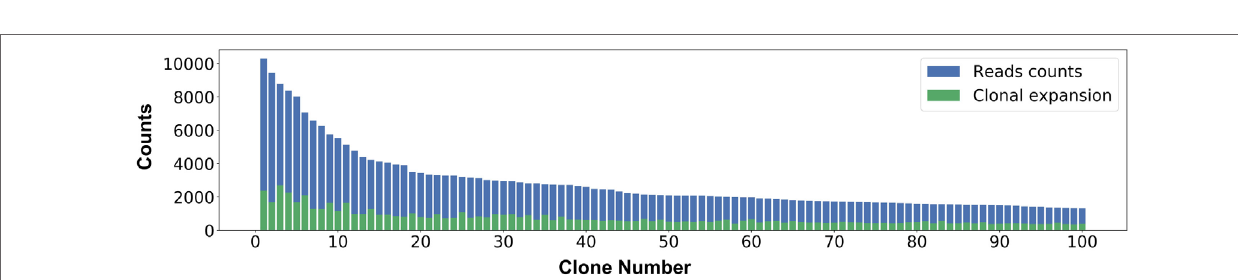
FIguRe 8 | Clonal expansion. The X axis shows the most prevalent 100 clones. For each clone, the Y axis represents the number of variable region amino acid reads supporting each clone (in blue) and the number of contributing unique variable region amino acid sequences (in green).